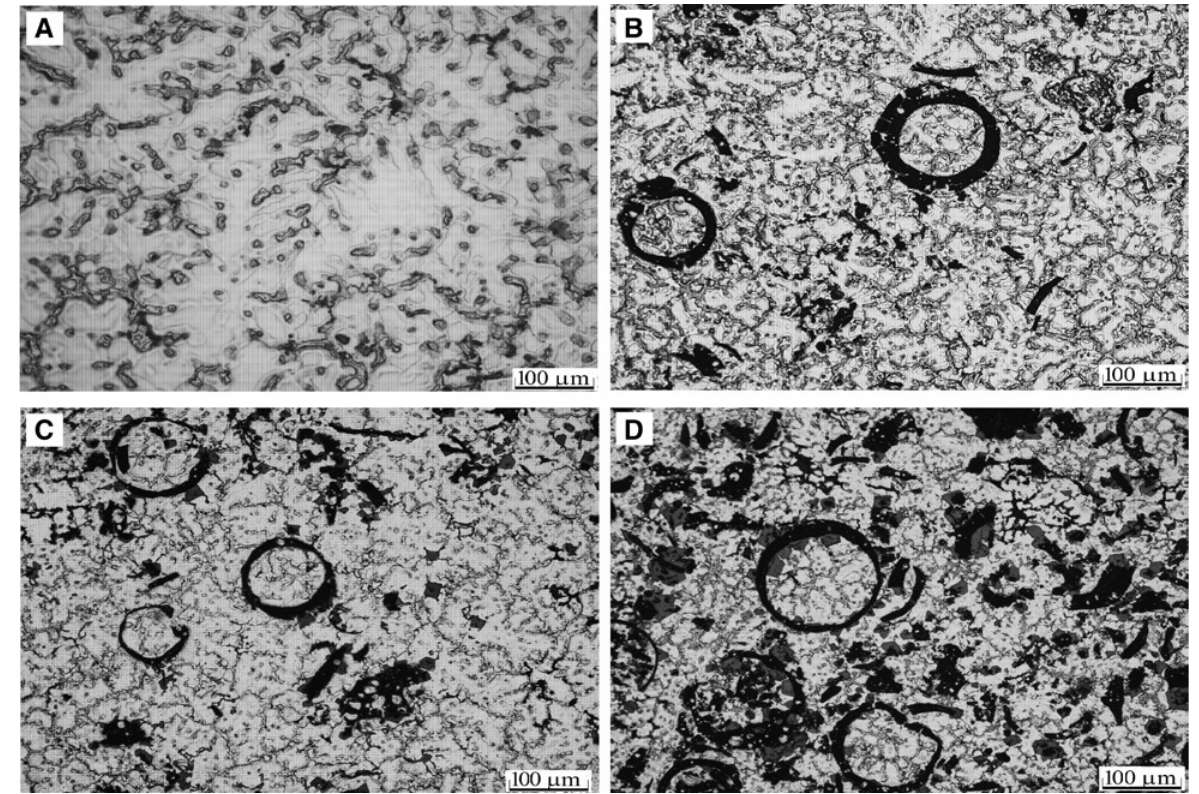
Figure 2: Microstructures of AZ91D Mg alloy and FAC/AZ91D composites with different FAC contents at room temperature. (A) AZ91D Mg alloy matrix, (B) 2 wt.% FAC/AZ91D composites, (C) 6 wt.% FAC/AZ91D composites, and (D) 10 wt.% FAC/AZ91D